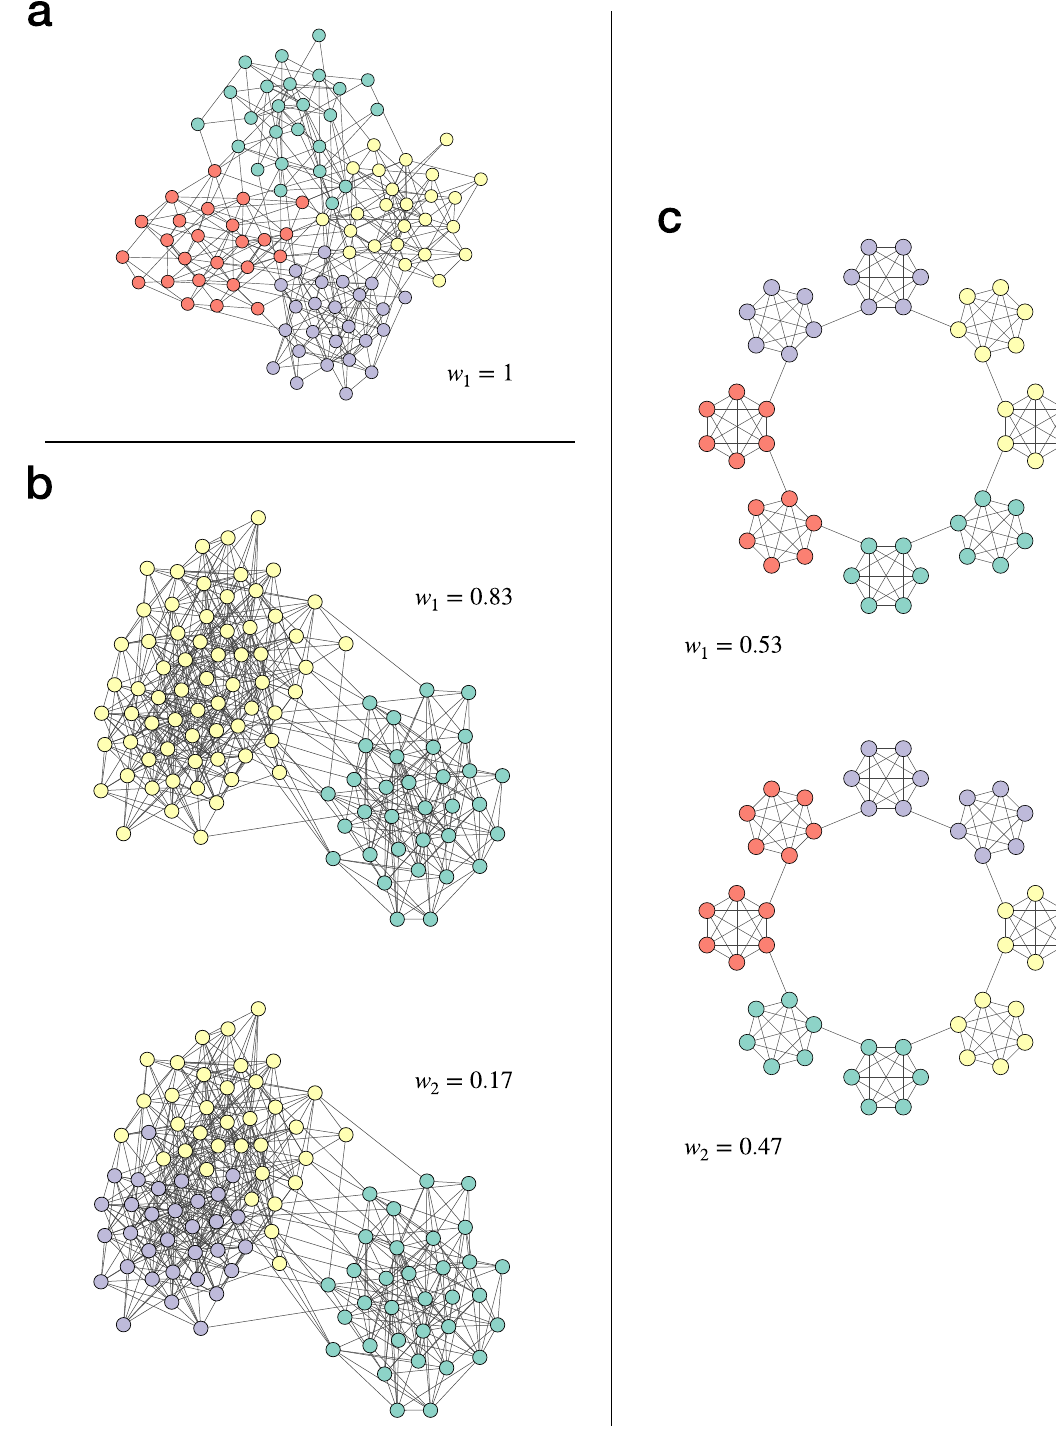
Fig. 2 Representative modes and their corresponding weights for three synthetic example networks. a Planted partition model with 100 nodes, 4 communities, and connection probabilities p in = 0.25 and p out = 0.02. b Network of 99 nodes generated using the stochastic block model with a mixing matrix of the form given in Eq. (7) with p s = 0.27, p m = 0.08, and p b = 0.01. c Ring of eight cliques of six nodes each, connected by single edges, based on the example in ref. 36 . Representative partitions are identi fi ed by minimizing Eq. (6) with penalty parameter λ = 1 for 10,000 community partition samples. The color of each node indicates its community membership within a partition, and w k is the weight of mode k